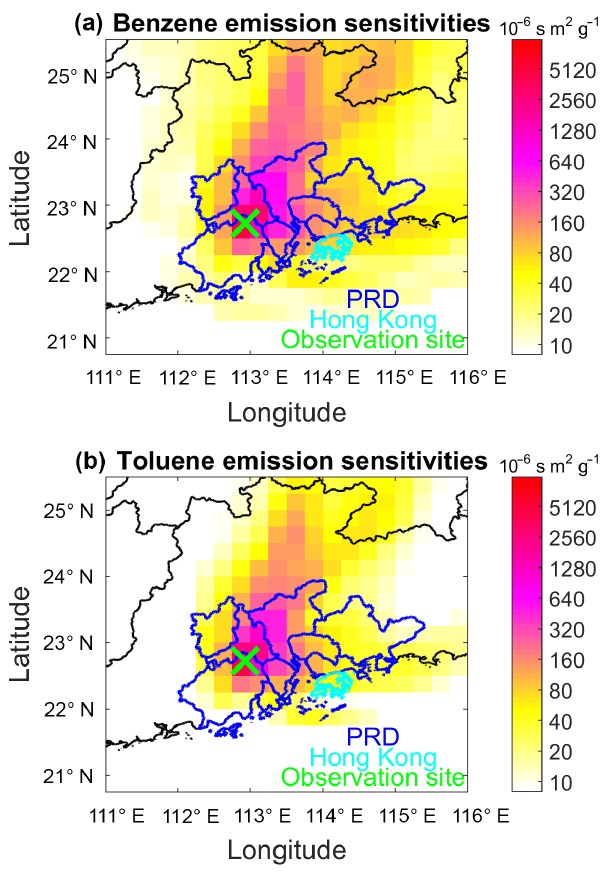
Figure 2. Average emission sensitivities of (a) benzene and (b) toluene for the Heshan observation site for 12–31 Novem- ber 2010. The green cross indicates the location of Heshan site. The blue and cyan lines represent PRD and Hong Kong boundary lines,